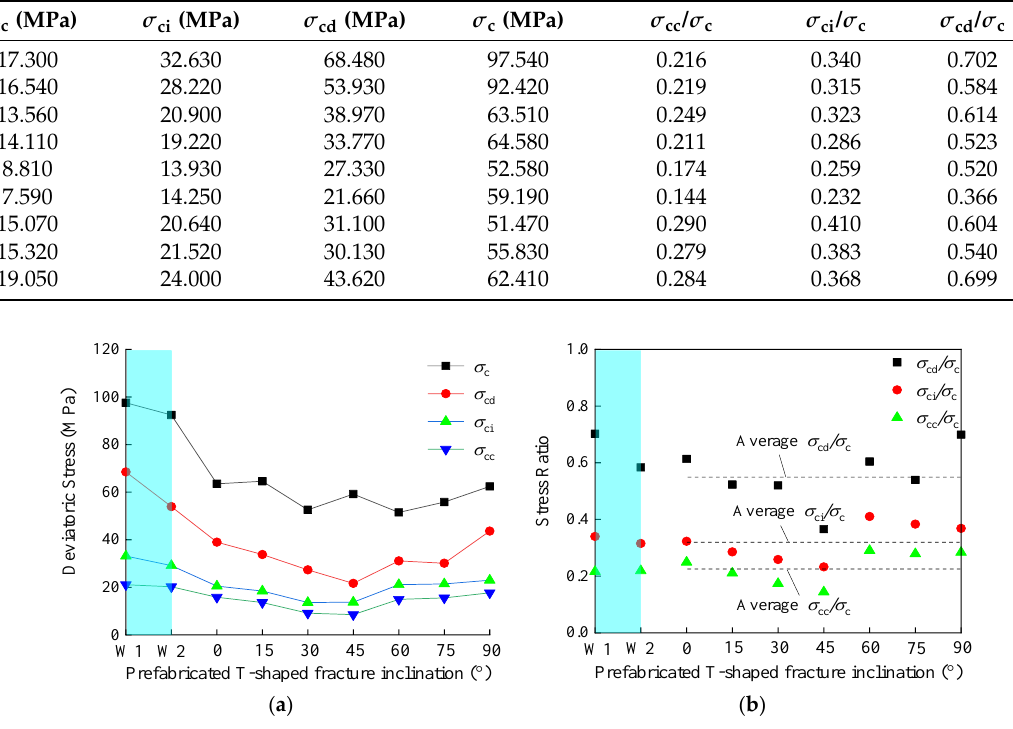
90 Figure 7. Drop Percentage in peak strength of intact specimens with water pressure, T - shaped fracture specimens compared to intact specimens without water pressure. 4.1.2. Deformation Characteristics In order to study the deformation characteristics of T - shaped fracture sandstone specimens under different fracture angles, the axial strain stiffness ξ ε 1 was used to quan- titatively characterize the ability of fractured sandstone to resist deformation and failure